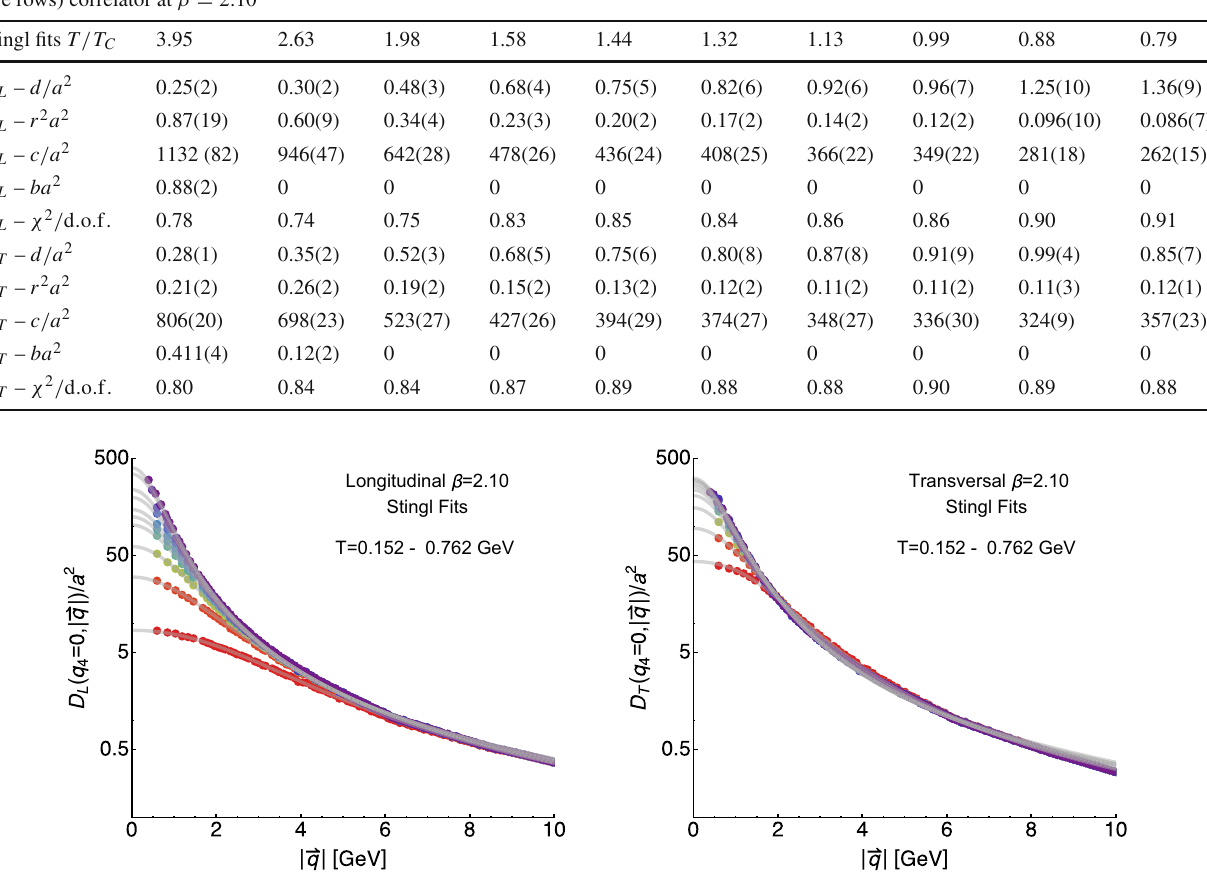
Fig. 1 The longitudinal (left) and transversal (right) gluon correlators at β = 2 . 10 evaluated at vanishing imaginary frequency q 4 = 0 but finite spatial momenta | q | for different temperatures T = 152 ... 762 MeV. The gray solid lines correspond to the results of the Gribov–Stingl fits